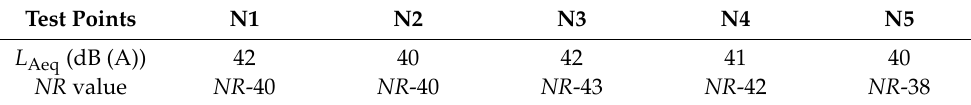
Table 6. The measurement results of the radiated noise in the test points N1 – N5.